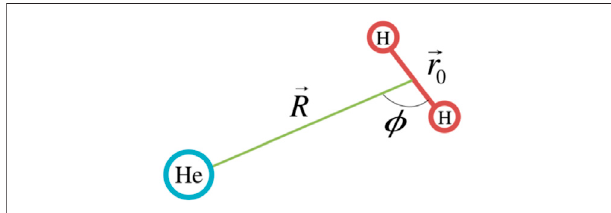
FIGURE 7 | Schematic representation of the He* − H 2 supermolecule. Reprinted (adapted) with permission Ref. [67]. Copyright (2017) American Chemical Society.